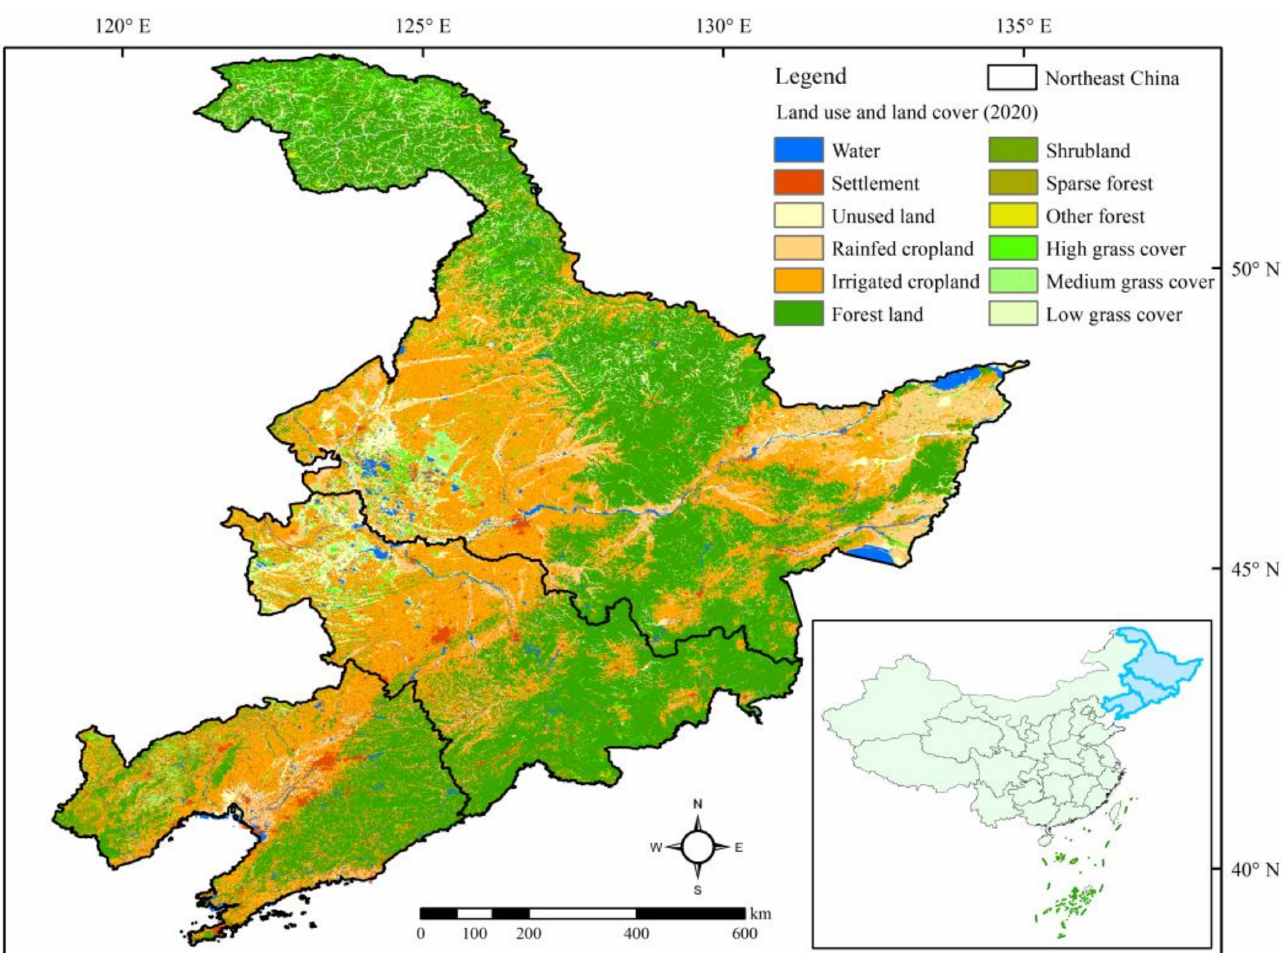
Figure 1. Maps showing the location of Northeast China and the 2020 land cover types. Northeast China has a temperate monsoon climate, including the middle temperate zone and the cold temperate zone from south to north. It has four distinct seasons, with warm and rainy conditions in summer and cold and dry conditions in winter. The average annual temperature is below 0 ◦ C, and the maximum reaches over 40 ◦ C. Annual aver- age precipitation varies greatly at different spatial and temporal scales ranging between 430.4 mm and 678.72 mm. In the past century, there has been a noticeable trend of tempera- ture increase, while the annual precipitation has shown a decreasing trend [23]. With